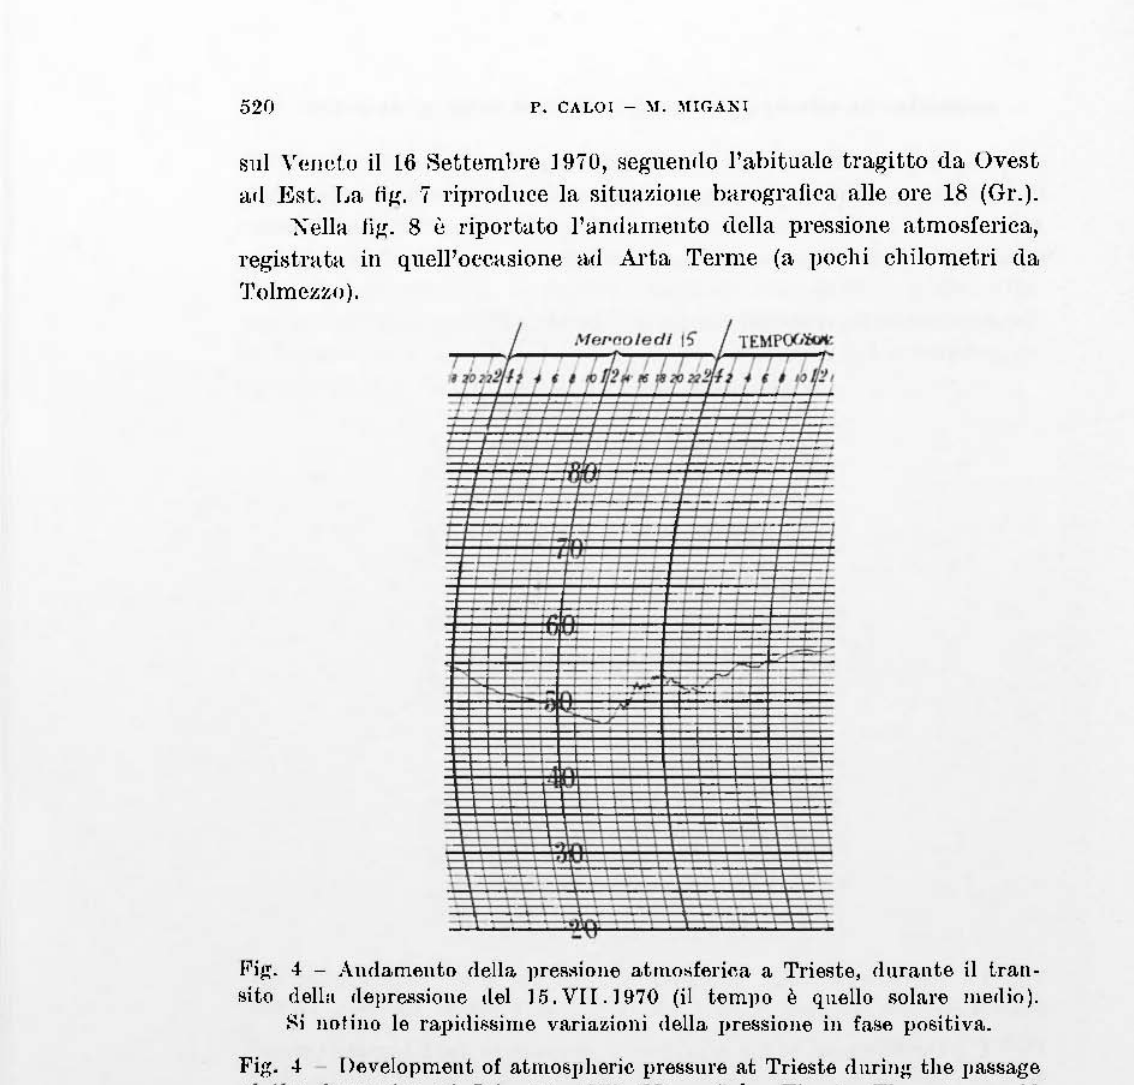
Fig. 4 [)evelopment of atmos]Jheric pressure at Trieste during the ]Jassage of the de]Jresgion of July II'i. 1970 (Meall Solar Time). The very rapi(1 variations of pre8Sure in the positive ]JhaRe are to he